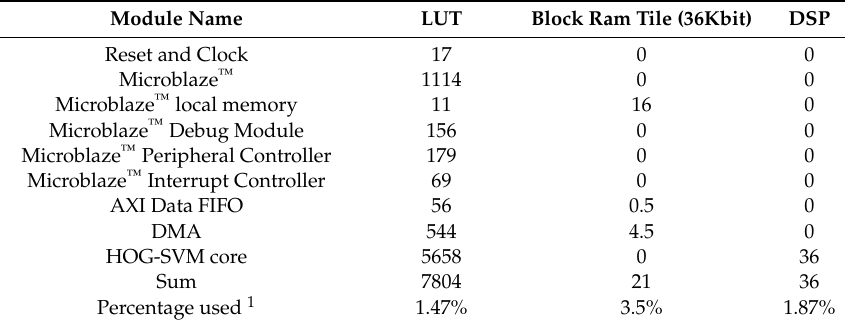
Table 5. Resource usage of the whole hardware–software system.